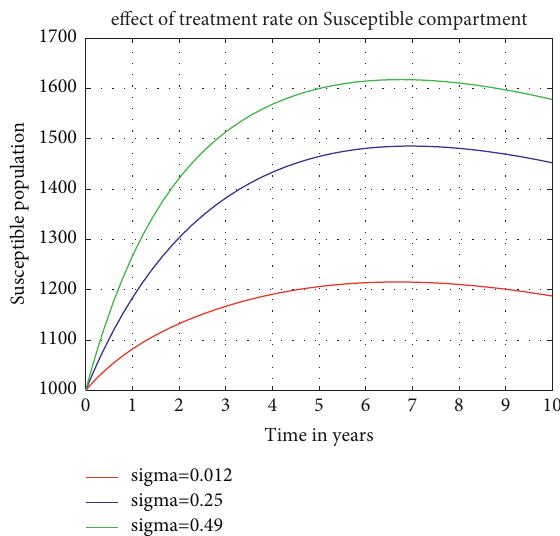
Figure 15: Effect of vaccination rate on acutely infected compartment.